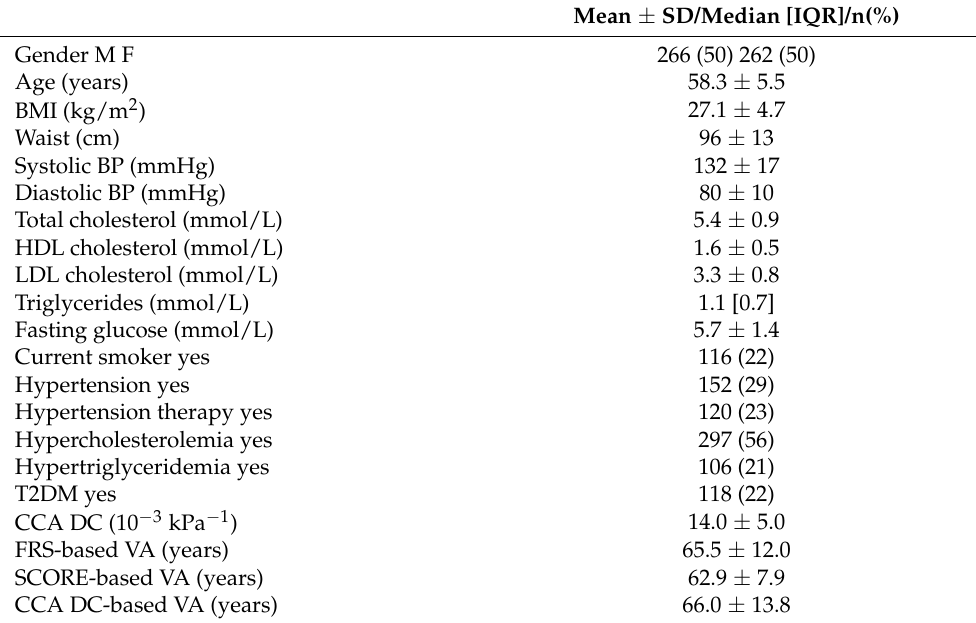
Table 1. Characteristics of study